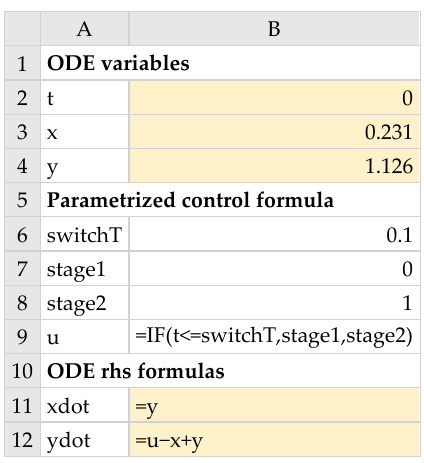
Figure 3. Spreadsheet model for IVP (7)–(9) with parametrized control function. The colored ranges are input parameters for the IVSOLVE Formula (11).